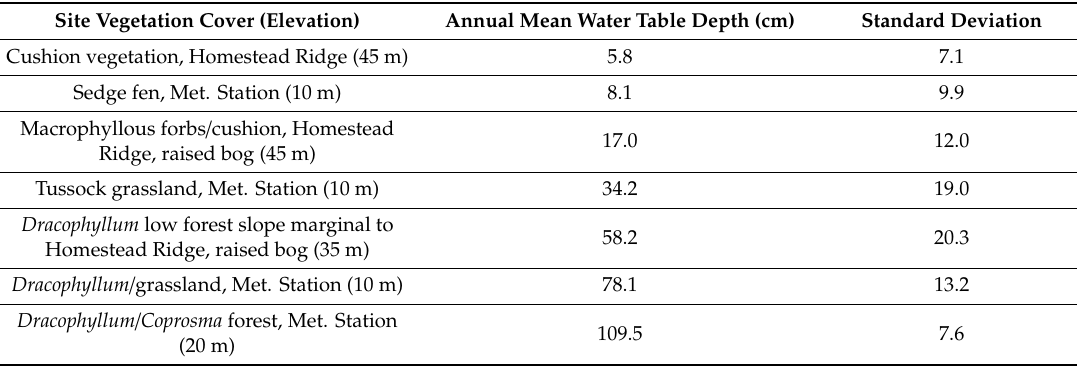
Figure 4. Homestead Ridge Bog. Vegetation cover percentage correlations with the water table. Green-filled bars are statistically significant negative correlations, yellow bars are statistically significant positive correlations, and empty filled bars are not statistically significant. Table 2. Vegetation cover in relation to the water table depth. Two series of daily water table measurements (February 1976 to February 1977, and December 1983 to November 1984) were made at permanent sites on Homestead Ridge raised bog and near the Meteorological Station, Perseverance Harbour, Campbell Island. Data from Reference [10].